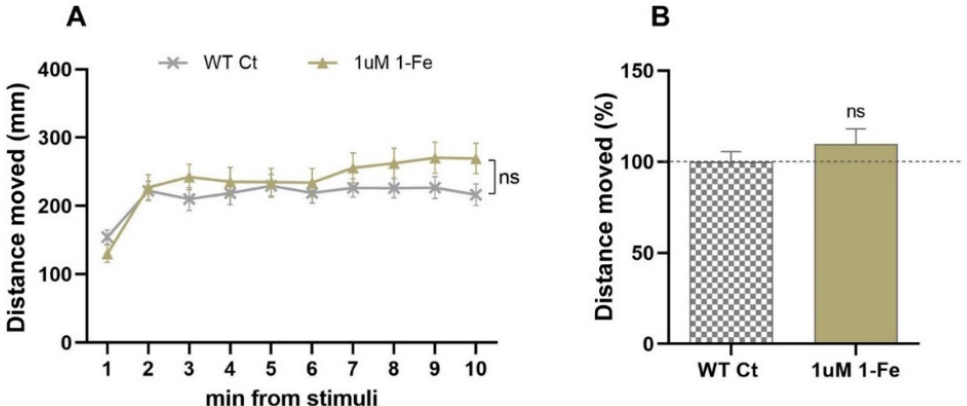
Figure 2. 1-Fe treatment improved mSOD1 larvae motor performance. ( A ) The distance that mSOD1 larvae swam per time bin of 1 min following light stimuli was averaged for all larvae. mSOD1 larvae were treated with either vehicle (0.1% DMSO; Ct), 0.05, 0.1, 1 or 5 µ M 1-Fe (* p < 0.05; linear mixed model, Tukey post hoc test, n = 94-6/group). ( B ) The change (%) in the distance the mSOD1-treated larvae swam compared to their vehicle-treated mSOD1 counterparts. The distances were averaged per fish for the whole period following light stimuli, scaled per plate and compared between treatments (* p < 0.05; *** p < 0.001; one-way ANOVA, Tukey post hoc test; n = 94-6/group). ( C ) Characteristic swimming paths of individual larvae for 60 s. Restoration of the swimming pattern was observed following treatment with 1-Fe .